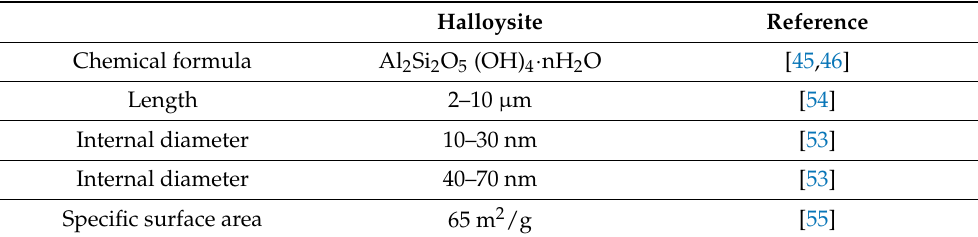
Table 2. Main physical characteristics of